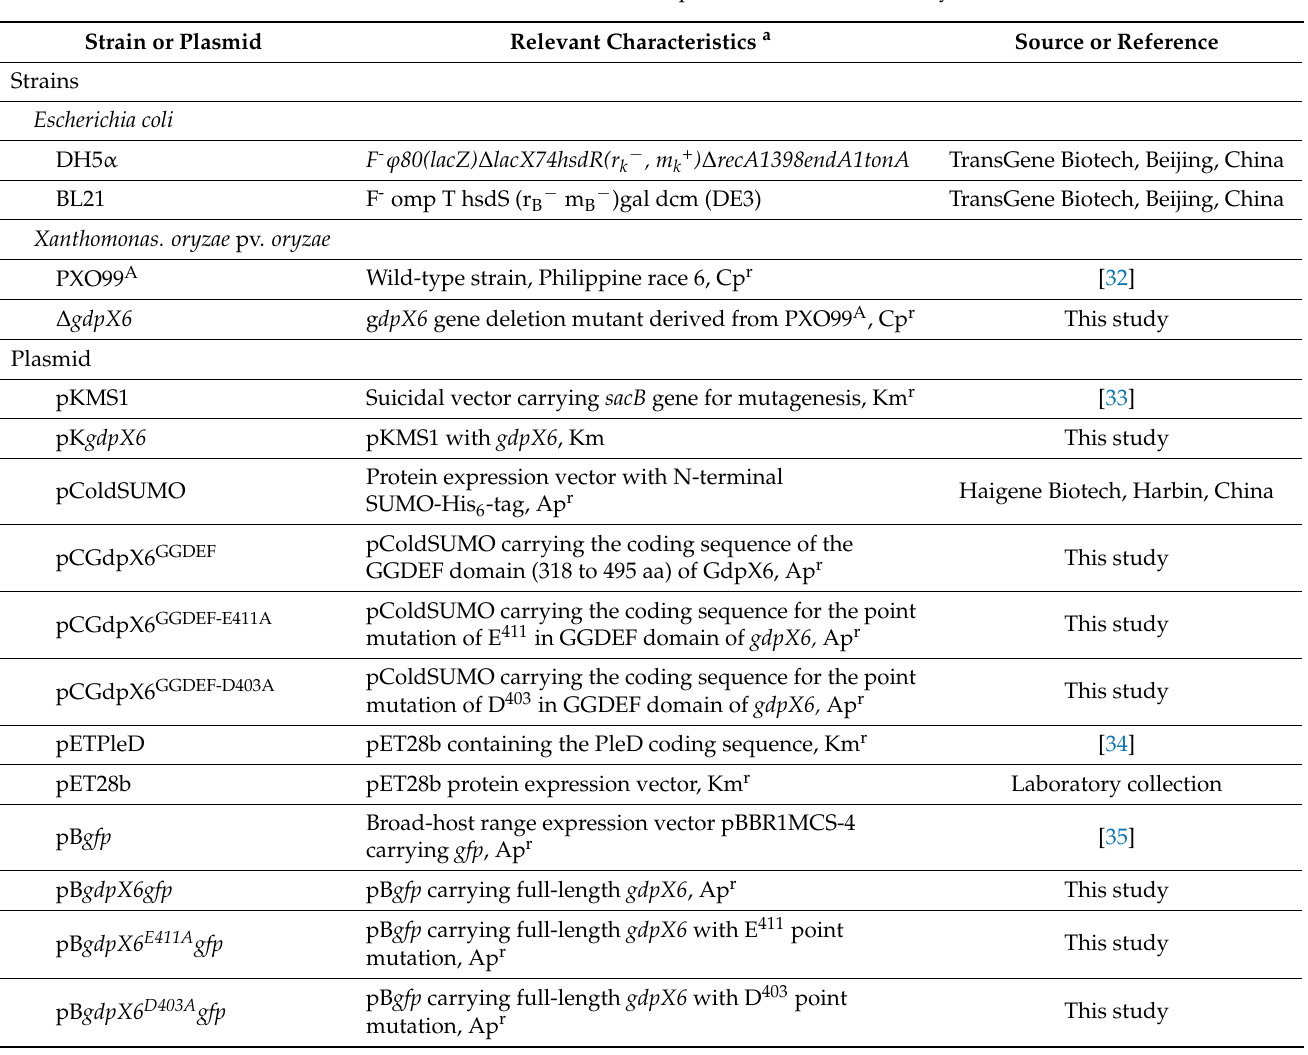
Table 1. The bacterial strains and plasmids used in this